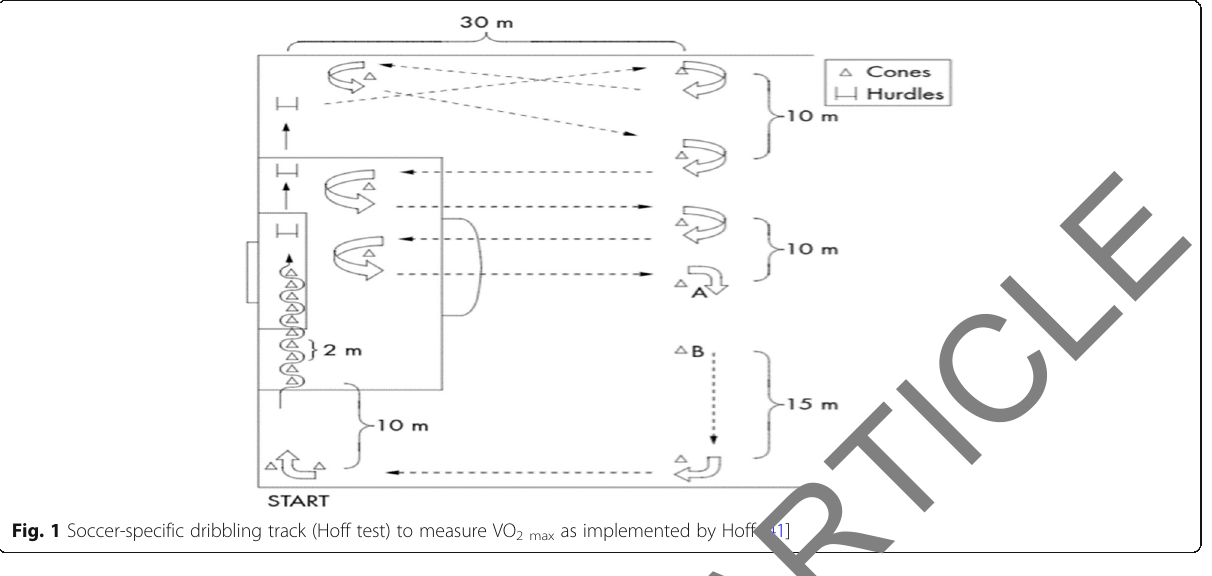
Fig. 1 Soccer-specific dribbling track (Hoff test) to measure VO 2 max as implemented by Hoff